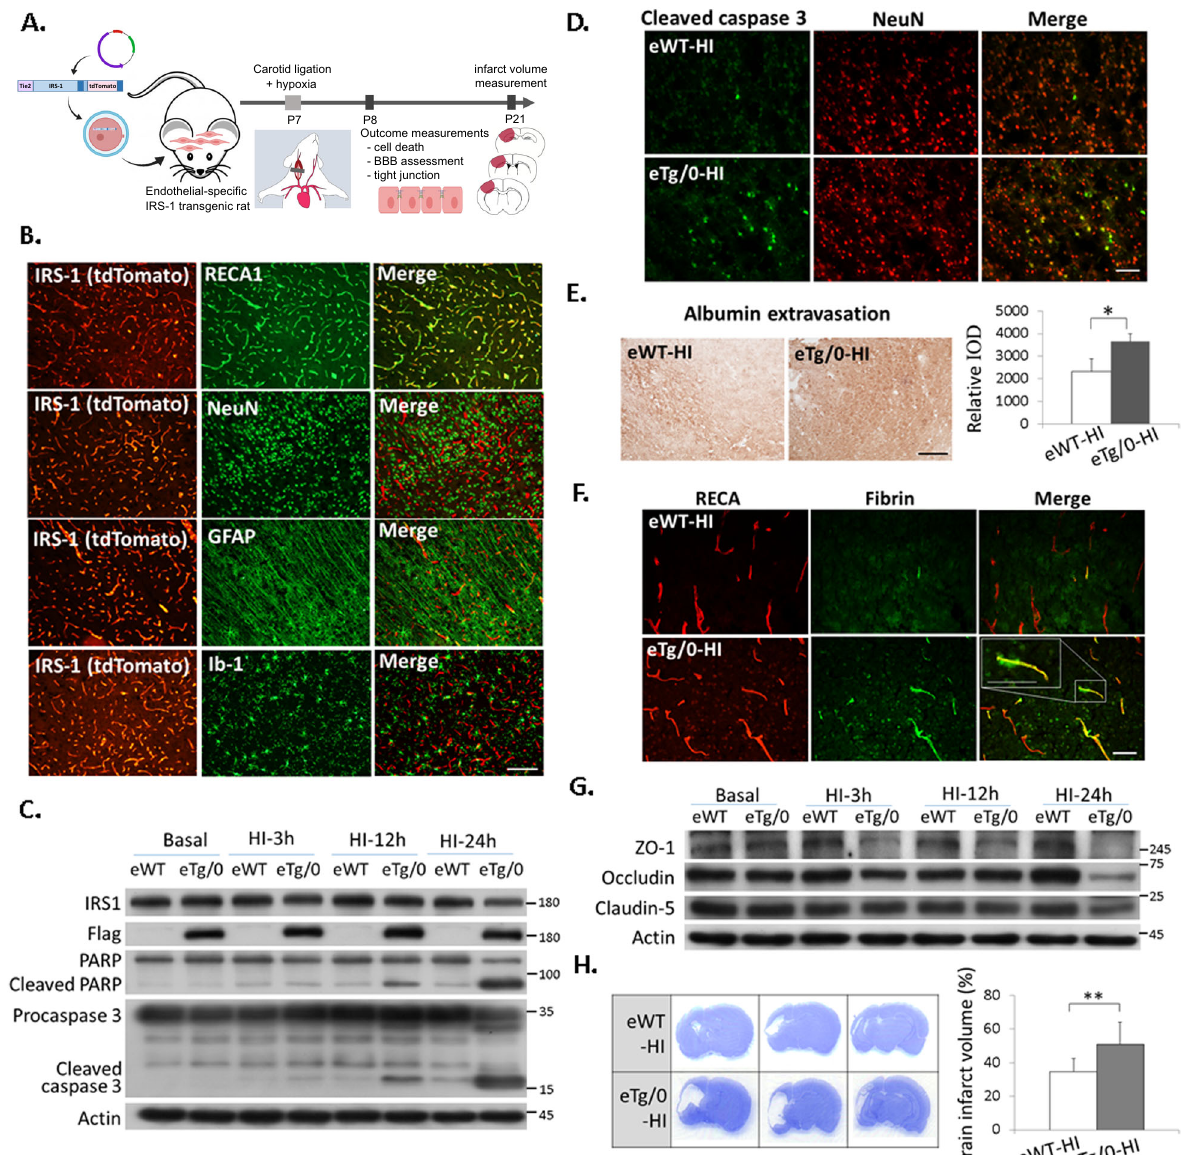
Fig. 3 Endothelial-speci fi c IRS-1 transgenic rats showed augmented neurovascular injury and brain damage after HI. A Diagram of the experimental procedure in the endothelial-speci fi c IRS-1 transgenic rats (eTg/0) and wild-type littermates (eWT) rats: HI on P7, and outcome assessments on P8 and P21. The transgene contains endothelial-speci fi c promoter (Tie2), full-length IRS-1 tagged with 3x Flag and IRES- directed tdTomato. B IRS-1/tdTomato was expressed speci fi cally on RECA ( + ) endothelium cells, and not on NeuN( + ) neurons, GFAP( + ) astrocytes, or Iba-1( + ) microglia in the cerebral cortex of P7 rat pups. Scale bar: 50 μ m. C The eTg/0 rats had increased levels of cleaved-PARP, and – capsease 3 after HI compared to the eWT rats. N = 4. D Increased cleaved caspase 3 ( + ) and NeuN ( + ) apoptotic neurons were noted in the eTg/0 rats compared to that in the eWT rats at 24 h after HI. Scale bar: 50 μ m. N = 4. E Representative images illustrate albumin extravasation in the cerebral cortex at 24 h after HI between eTg/0 and eWT rats, and the relative integrated optic density (IOD) of albumin signal was quanti fi ed. Scale bar: 125 μ m. Independent t -test was used for statistical analysis ( N = 6, P = 0.001, t = − 5.040). The data are presented as mean ± SD. * P < 0.05. F The extravascular fi brin is more in the eTg/0 rats compared to that in the eWT rats at 24 h after HI. Scale bar: 50 μ m. Inset scale bar: 50um. N = 4. G Immunoblotting analysis of tight junction proteins in the brain of eTg/0 rats. N = 4. H The brain infarct volume was compared between eTg/0 and eWT rats. Independent t -test was used for statistical analysis ( N = 12, P = 0.002, t = − 3.638). The data are presented as mean ± SD. ** P < 0.01. caused increased vascular permeability and tight junction protein neuronal death and decreased BBB disruption in the neurovas- disassembly. Rapamycin treatment preserved the loss of tight cular unit, and showed reduced brain damage after HI. In contrast, junction proteins, attenuated BBB leakage and neuronal apoptosis, the endothelial IRS-1 transgenic rat pups showed augmented and provided signi fi cant neuroprotection after HI in the endothe- apoptotic neuronal death, BBB disruption, reduced tight junction lial IRS-1 transgenic pups. Overall, our data demonstrate that proteins in the neurovascular unit, and exaggerated brain damage neuronal IRS overexpression protects neurovascular integrity and outcome after HI. Furthermore, our in vivo and in vitro studies is neuroprotective against HI. In contrast, vascular endothelial found that mTOR overactivation induced by endothelial IRS-1